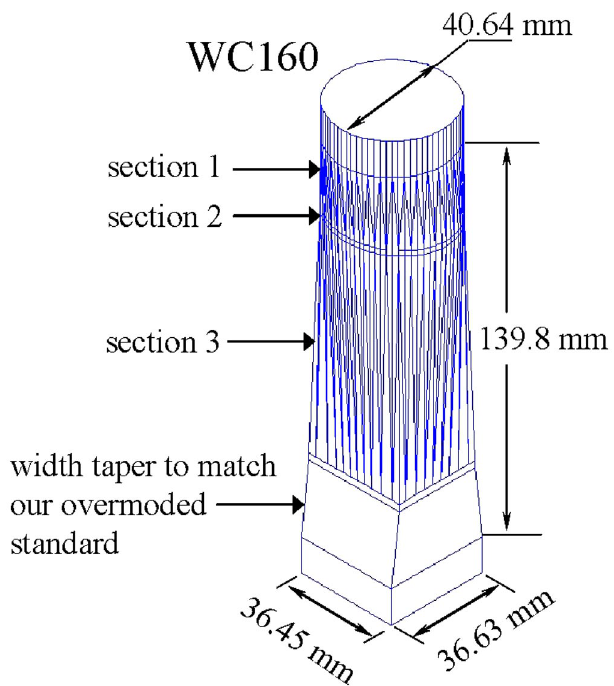
FIG. 3. (Color) Dual-mode taper